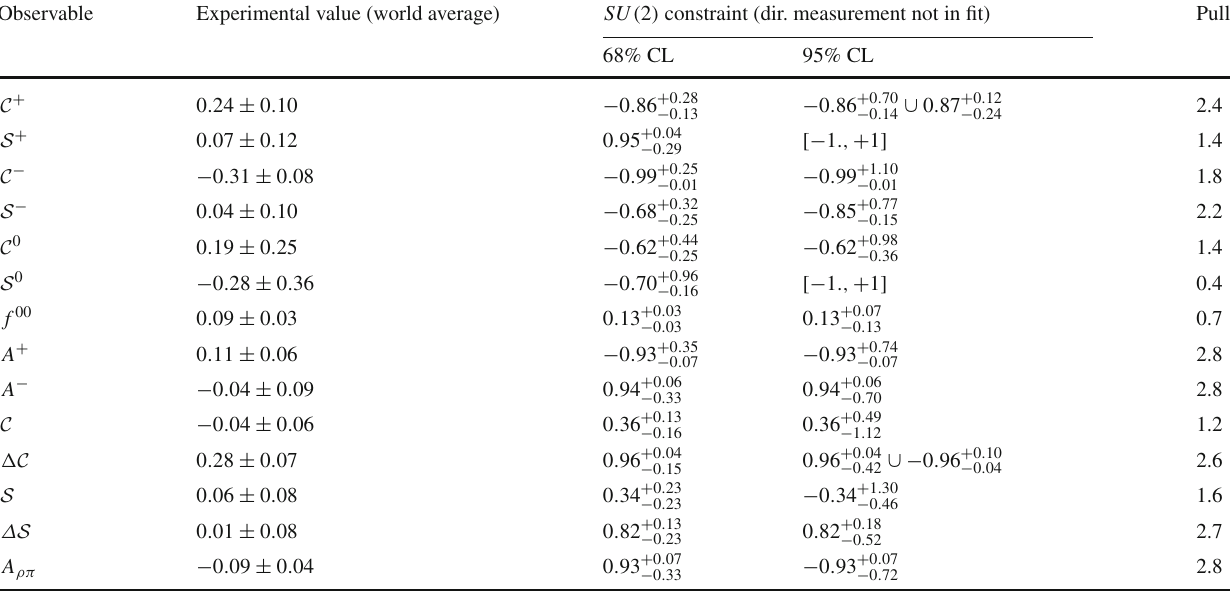
Table 18 Indirect SU ( 2 ) isospin determination of the B 0 → π + π − π 0 parameters derived from the combined U and I coefficients, compared to their experimental